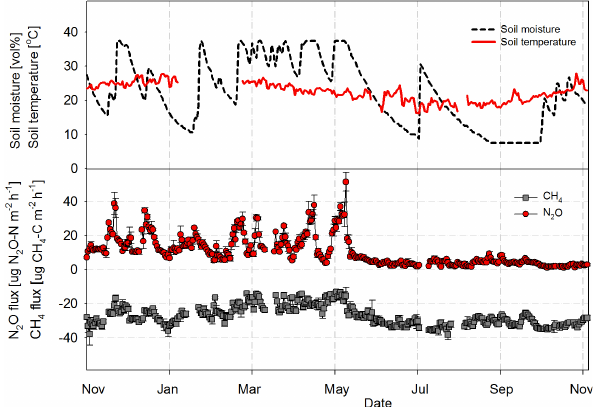
Fig. 1. Seasonal variability of daily average soil volumetric water content (at 10cm depth) and soil temperature (at 5cm depth) as well as of soil nitrous oxide and methane fluxes at the H¨oglwald Forest site in the years 1995 and 1997.